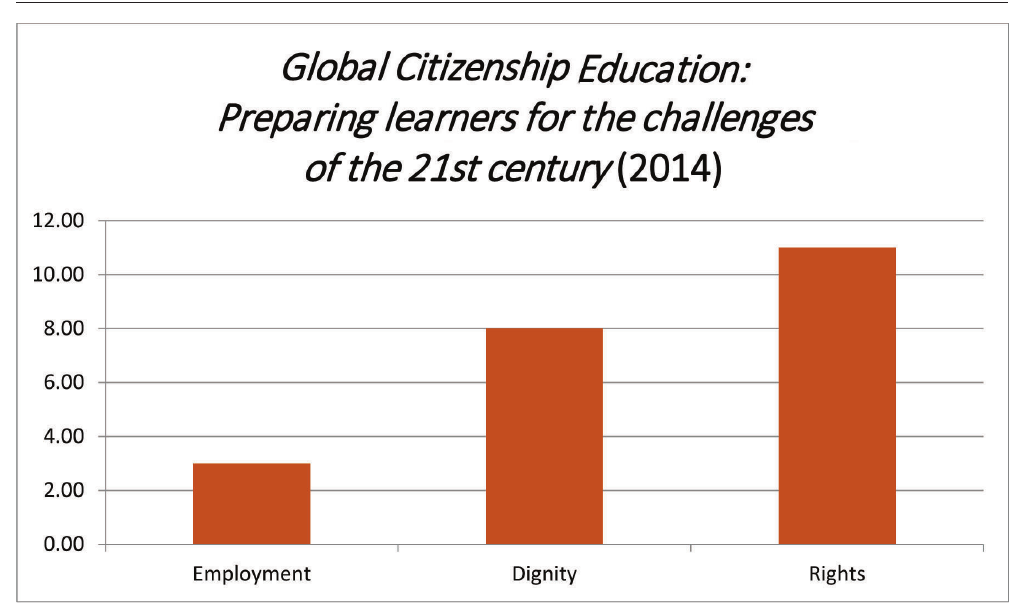
Figure 4: UNESCO (2014) Cluster 2